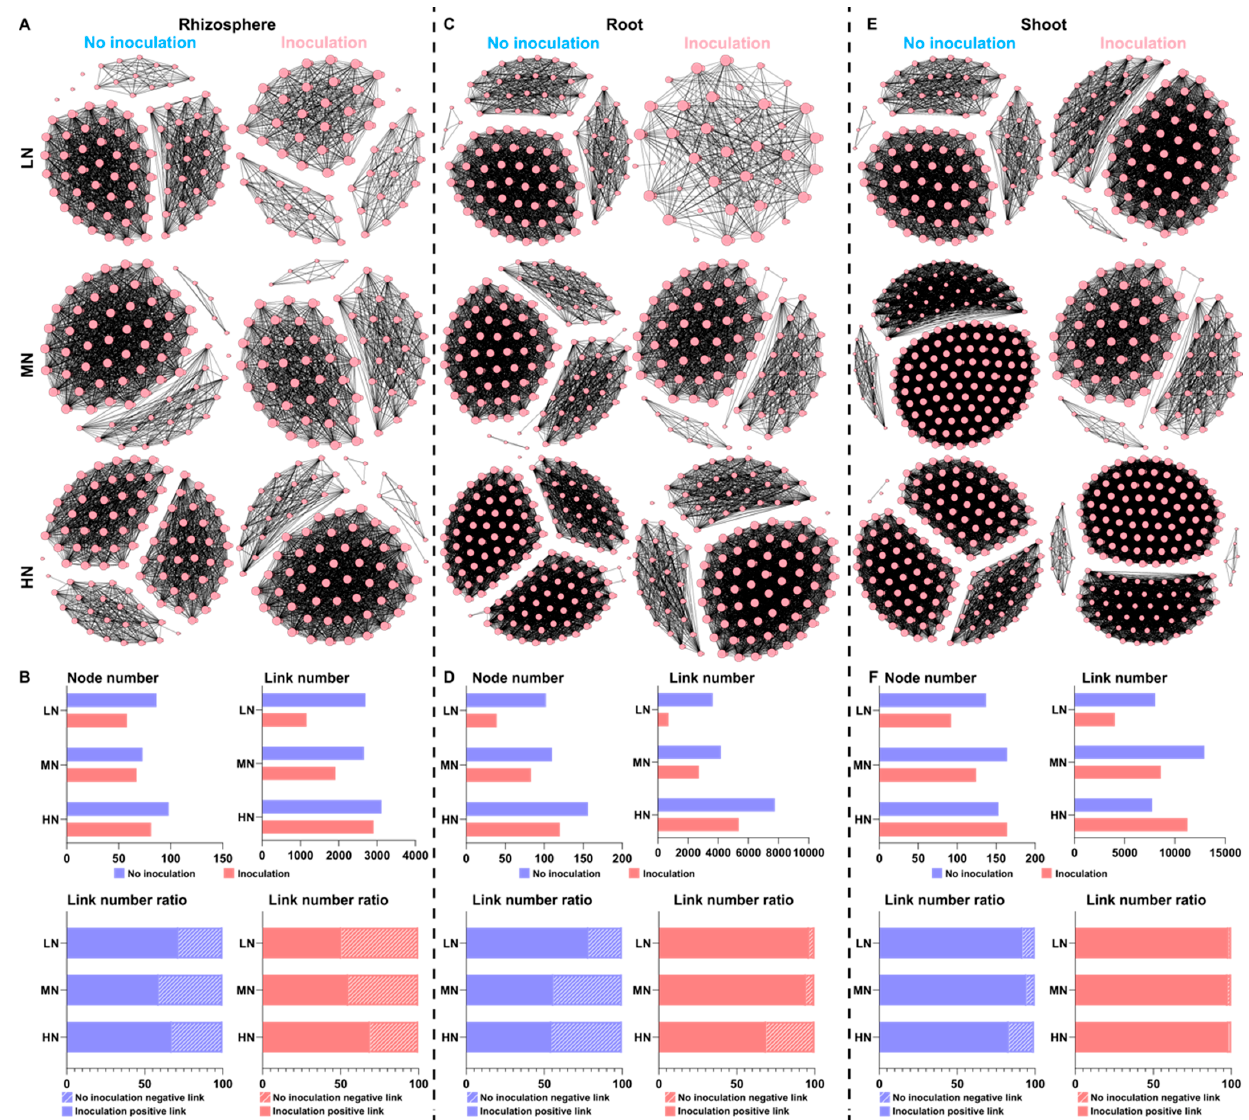
Figure 9. Co-occurrence network of biology–biology, representing the diazotrophic interactions in the rhizosphere ( A ), root ( C ) and shoot ( E ) at different nitrogen levels. The topological characterizations include the node number, link number and link number ratio (positive link versus negative link; ( B , D , F )). The connections are Spearman correlations with significance ( p < 0.05) and high significance (0.6 < |r| < 1).